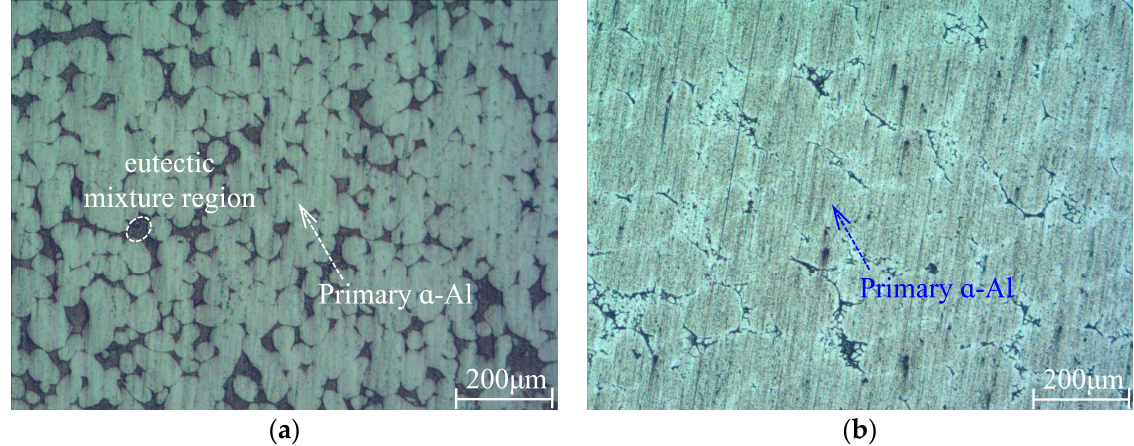
Figure 5. Microstructures made by upsetting with semi-solid slurry: ( a ) A356; ( b )